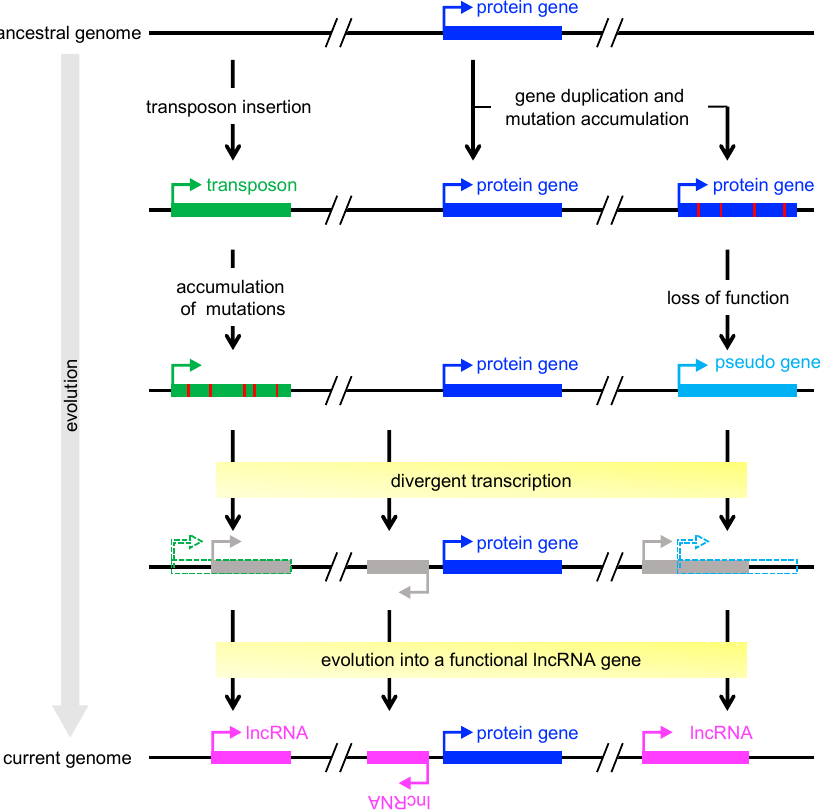
Figure 2. Schematic model of lncRNA emergence. A transcription unit of long non-coding RNA (lncRNA) could originate from pre-existing transcription regulatory sequences of transposable elements ( left ), protein-coding genes ( middle ), or pseudogenes ( right ). Transposable elements could be a source of sequences and signals essential for transcription (e.g., transcription start sites) and processing (e.g., splice and polyadenylation sites) [130], whereas protein-coding genes and pseudogenes could provide transcription factor–binding sites that serve as promoters and enhancers [133]. Gray boxes indicate transcribed loci of unknown function. Red vertical bars indicate mutations.